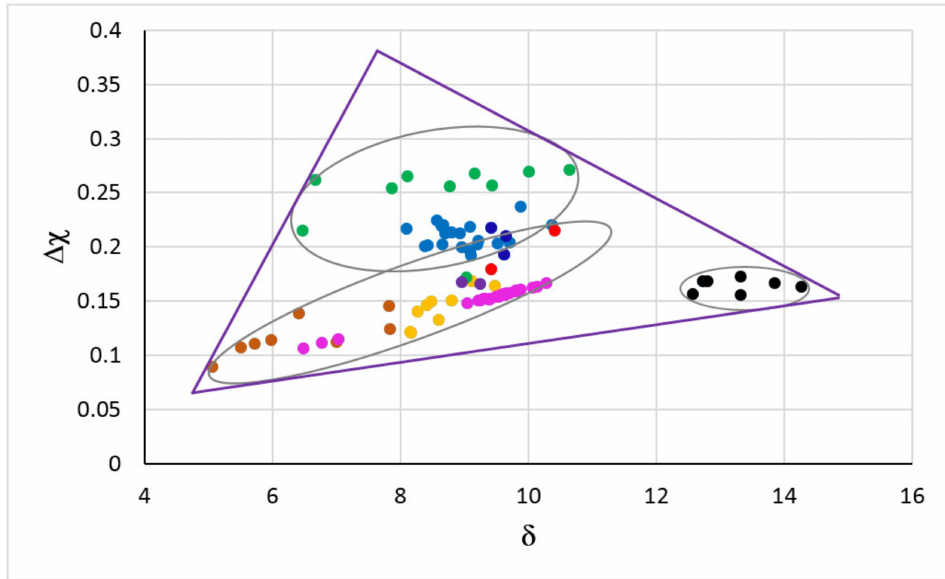
Figure 1. ∆ χ versus δ map of RM(Nb)ICs, RM(Nb)ICs/RCCAs, RM(Nb)ICs/RHEAs and RHEAs or RCCAs with addition of Nb and Si. RM(Nb)ICs: Orange circles for alloys of B-free Nb-SM-Met- TM-RM systems with Nb ss and Nb 5 Si 3 with/without Laves phase; blue circles for alloys of B-free Nb-Si-TM-RM systems with Nb ss and Nb 5 Si 3 ; black circles for alloys of Nb-SM-B-TM-RM systems with Nb ss and 5-3 silicide alloyed with boron [7]. SM = simple metal and Met = metalloid element (Al, B, Ge, Si, Sn). TM = transition metal (Cr, Hf, Ti); RM=Mo, Ta, W. RHEAs and RCCAs; green circles for alloys with bcc solid solution plus M 5 Si 3 silicide(s) [2]; red circles for alloys with bcc solid solution plus M 5 Si 3 silicide(s) and Laves phase(s) [2]; darker orange circles for alloys with bcc solid solution plus Laves phase without M 5 Si 3 silicide [17] (M = TM, RM). RM(Nb)ICs/RCCAs; purple circles for the alloys OHS1 [18] and ZF9 [19] with Nb ss and Nb 5 Si 3 ; dark blue circles for the alloys JZ3+, JZ4 and JZ5 with Nb ss and Nb 5 Si 3 [20,21]. RM(Nb)ICs/RHEAs; pink circles for the alloys MG5, MG6 and MG7 with Nb ss and Nb 5 Si 3 and other intermetallics [11,22]. For triangle see text. For the nominal compositions of the alloys see the Appendix A.